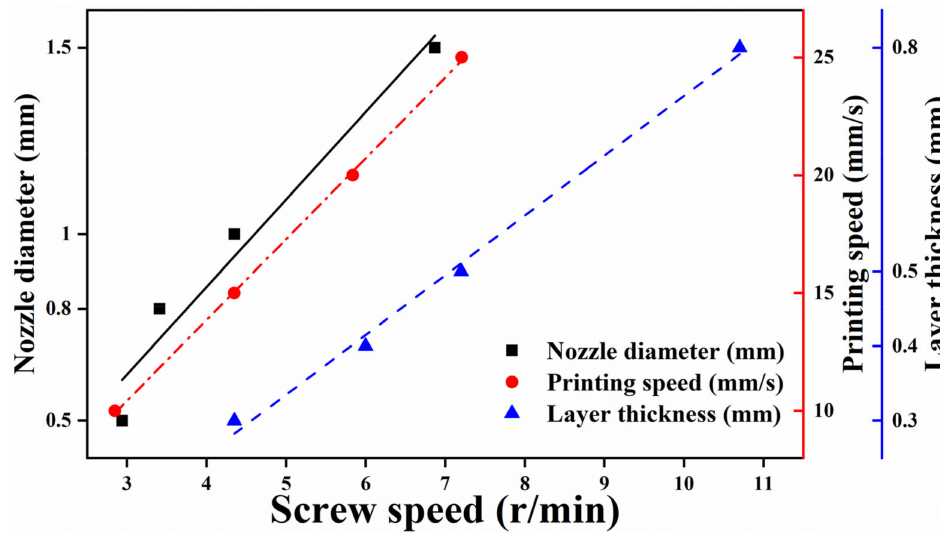
Figure 3. Relationship between screw speed and forming